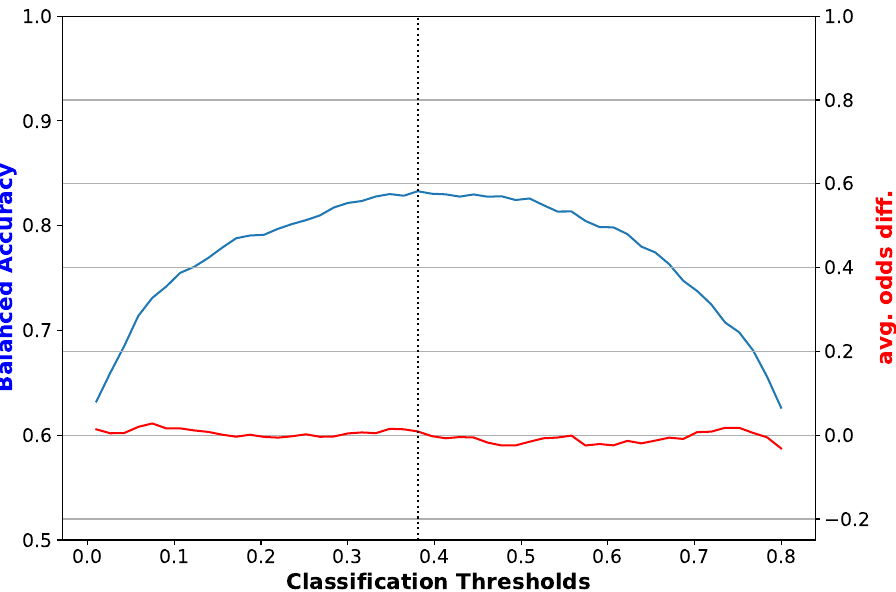
Figure 5. Balanced accuracy and average odds difference versus classification threshold for a logistic regression classifier with reweighing. The dotted vertical line is the threshold that maximizes balanced accuracy. The plot shown corresponds to one of the folds of